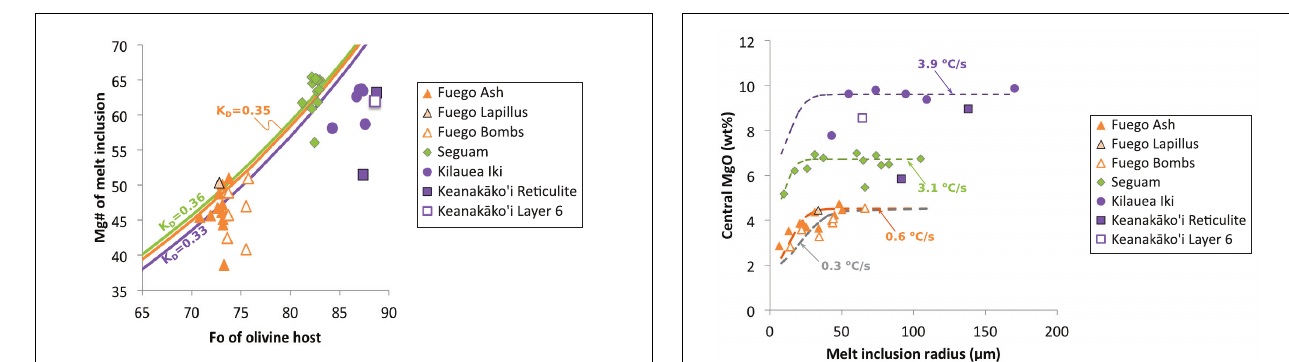
FIGURE 3 | MgO concentration measured in the centers of melt inclusions (not corrected for post-entrapment crystallization) plotted against inclusion radius. Each point represents an average of ∼ 5 MgO measurements. Inclusions from Fuego with radii < ∼ 50 µ m and inclusions from Seguam with radii < ∼ 30 µ m are depleted in MgO in their centers due to the propagation of a diffusive boundary layer of MgO depletion produced during syneruptive olivine crystallization on the inclusion walls. Colored dashed curves show relationships between central MgO concentrations and inclusion radii calculated by a one-stage linear cooling model. The initial MgO concentration and cooling rate for each model were set to the average best-fit values determined by fitting MgO concentration gradients in individual melt inclusions from Fuego ash and bombs, Seguam, and Kilauea Iki (see Figure 4 ). The purple curve uses an initial MgO of 9.6 wt% and a cooling rate of 3.9 ◦ C/s (designed to match the Kilauea Iki melt inclusions); the green curve uses an initial MgO of 6.7 wt% and a cooling rate of 3.1 ◦ C/s (to match the Seguam inclusions); the orange curve uses an initial MgO of 4.5 wt% and a cooling rate of 0.6 ◦ C/s; and the gray curve uses an initial MgO of 4.5 wt% and a cooling rate of 0.3 ◦ C/s (to match the Fuego